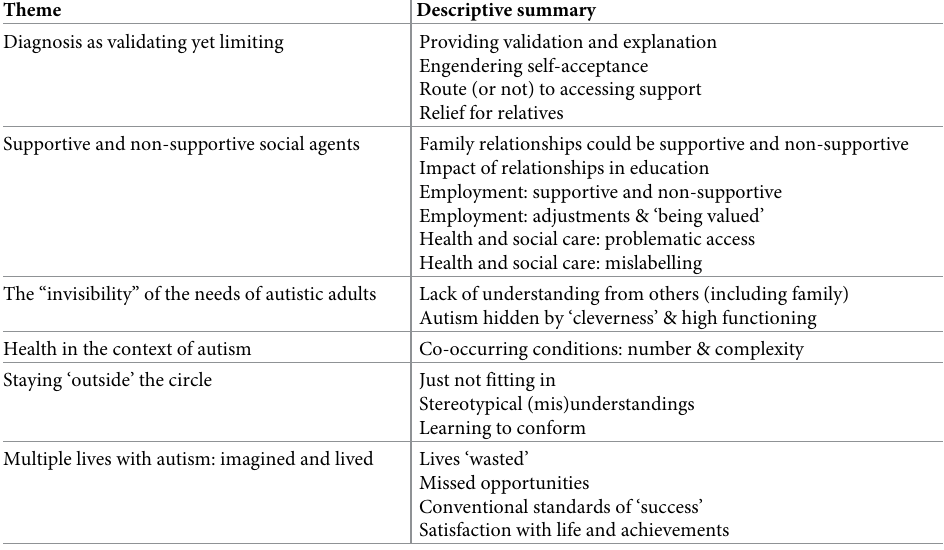
Table 3. Summary of qualitative